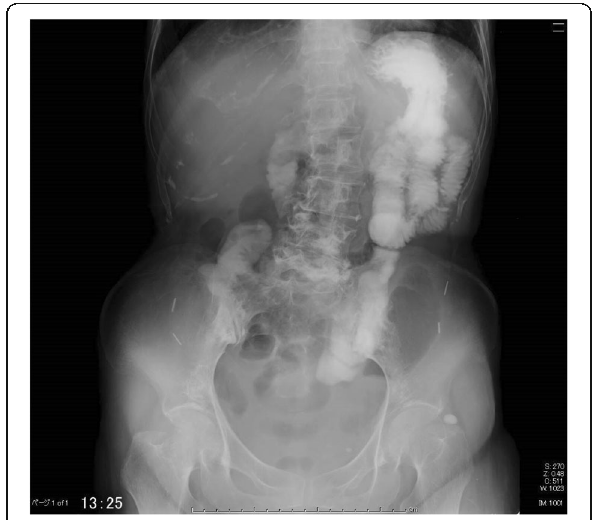
Fig. 3 An upper gastrointestinal contrast examination shows that the peristaltic movement of the upper gastrointestinal tract and the stomach had improved after the splanchnic nerve